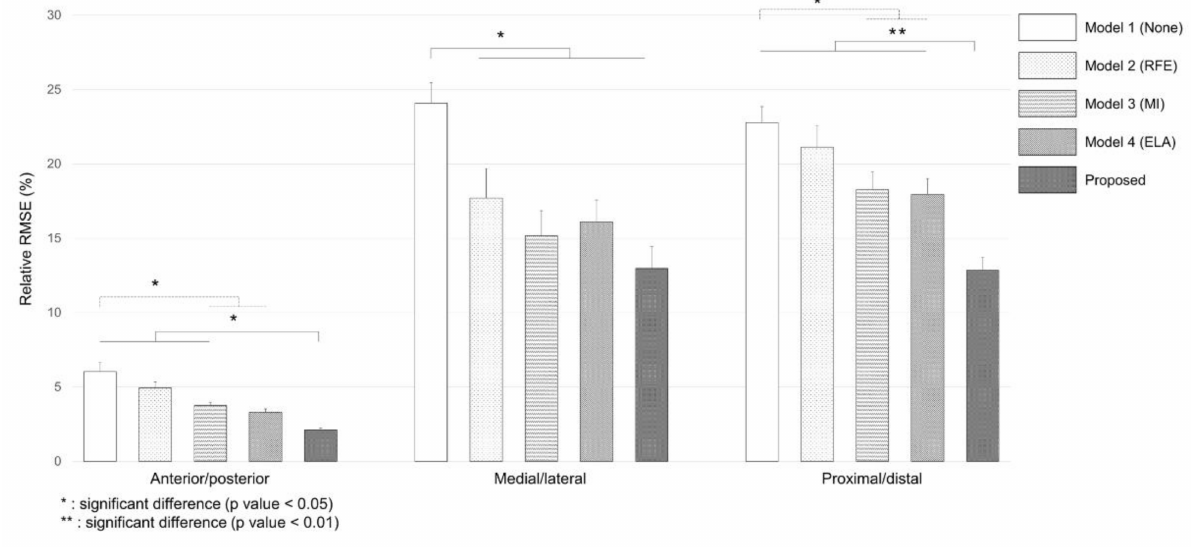
Figure 14. Average relative root mean square errors of CG prediction for five different